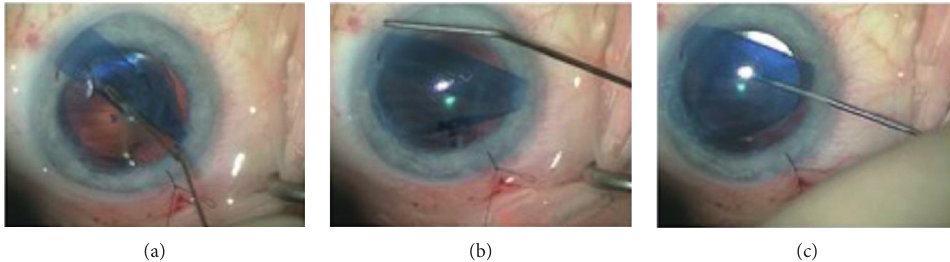
Figure 5: (a) Tap to unfold DMEK tissue; (b) tap to center the tissue; (c) DMEK orientation